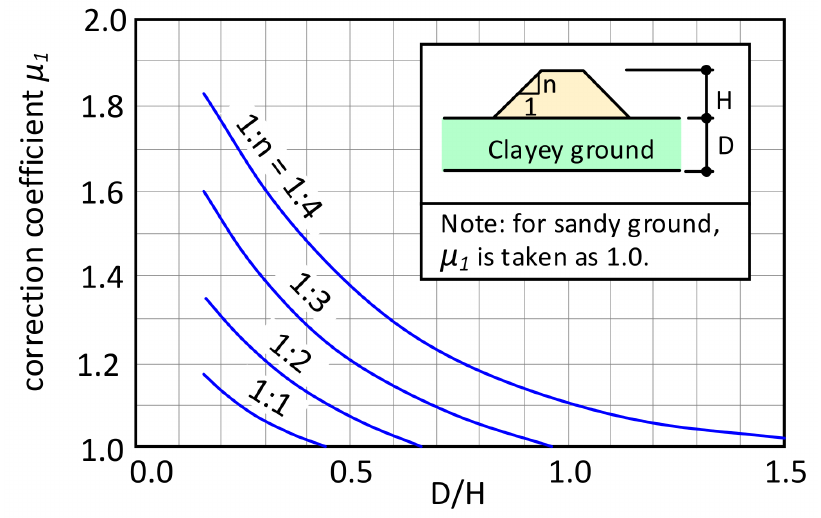
Figure 4. The relationship between the correction coefficient ( µ 1 ) and D/H. Table 2. Correction coefficient µ 2 for the influence of horizontal length in front of the embankment